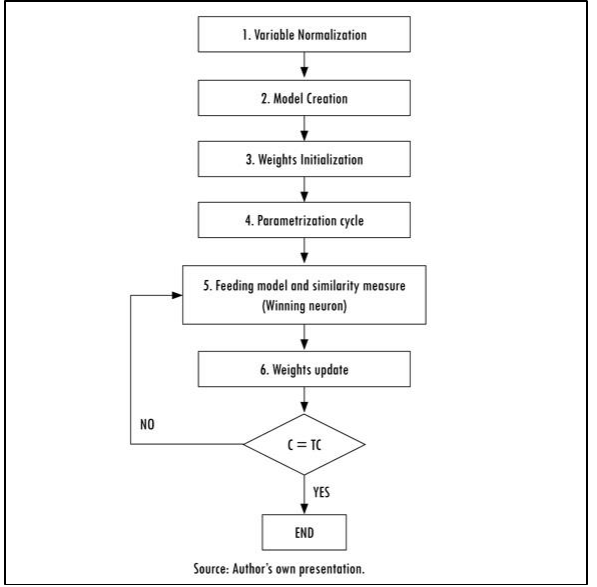
Figure 3: Feed-forward (FNN) artificial neural network (Krenker et al., 2011) Figure 4: Kohonen’s network operation (Kohonen T., 1998)